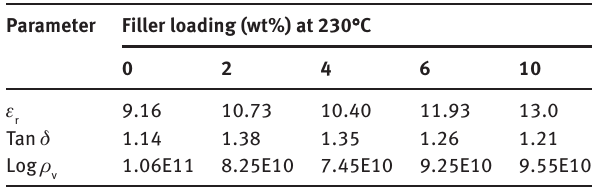
Figure 7: Effect of temperature on ρ